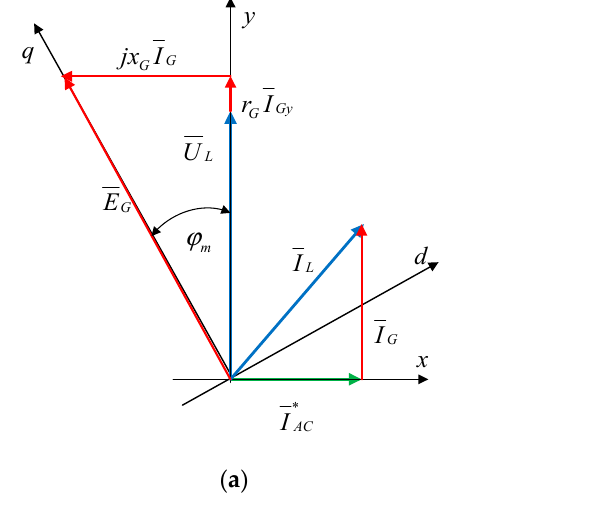
Figure 5. Vector diagrams of the system with load compensation with an active converter generating only reactive current (reactive power): ( a ) The AC fully compensates for the reactive power of the load, ( b ) AC case generates reactive current greater than the current required by the load; the generator is loaded with negative (capacitive) reactive power. (red vectors—refer to PMSG, blue vectors—refer to load, green vectors—refer to